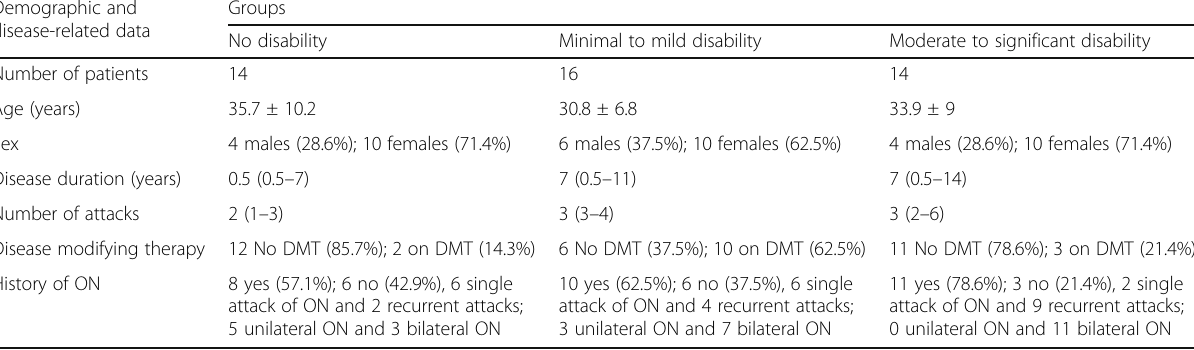
Table 1 Demographic and disease variables of patients with MS Demographic and disease-related